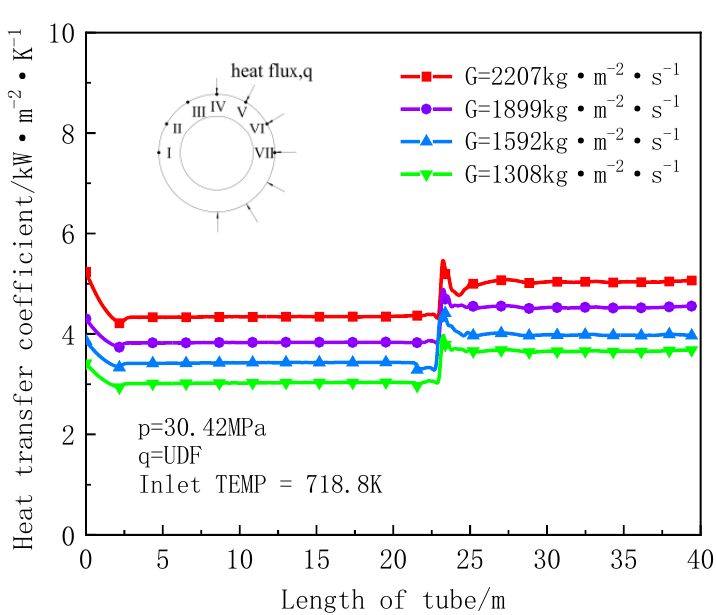
Figure 13. Heat transfer coefficient of tube length at different mass fluxes ( p = 30.42 MPa, T = 718.8 K, G = 1308~2207 kg/(m 2 · s)).